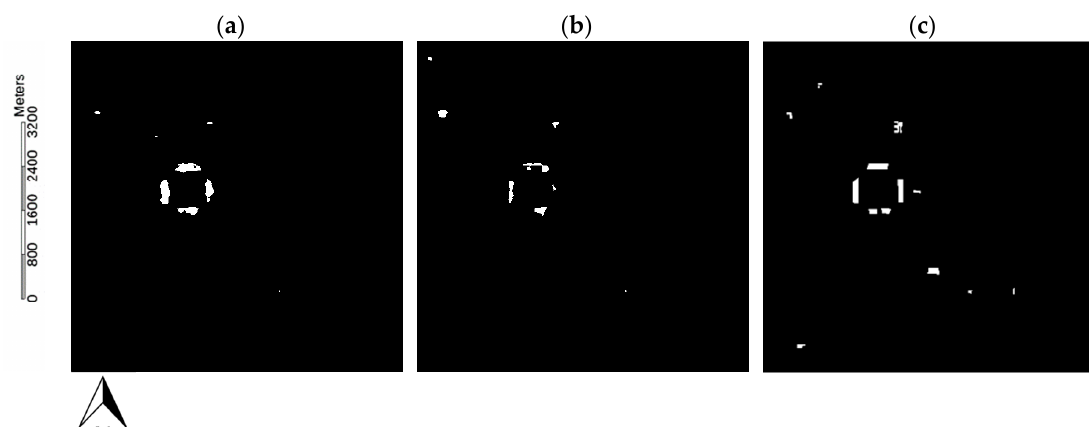
Figure 8. Results of the Bangkok site in the second area of the SAR pair of 12 January 2009/21 November 2009, where the size of each image is 6 × 6 km: ( a ) Additional skip connection on one side of the network; ( b ) Additional skip connection on both sides of the network, ( c ) ground truth.